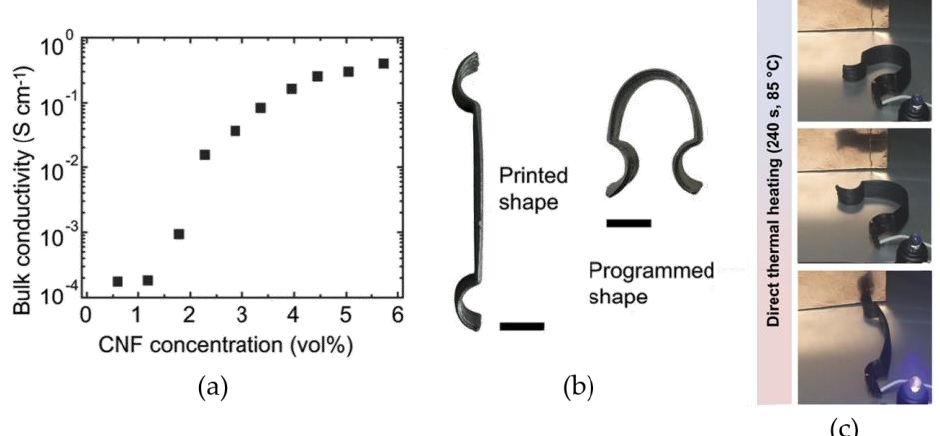
Figure 25. Electrical conductivity and multi-functionality of composite SMPs. ( a ) The plot of electrical conductivity dependence on CNF concentration where conductivity increases with increasing CNF concentration. ( b ) An electrically conductive (5.6 vol% CNF) part is shown in its printed or primary shape and its programmed shape. The component in ( b ) is connected to a power source and thermally actuated to change its form. A complete circuit in ( c ) where an LED become powered and lights up after 240 s at 80 ◦ C [197].